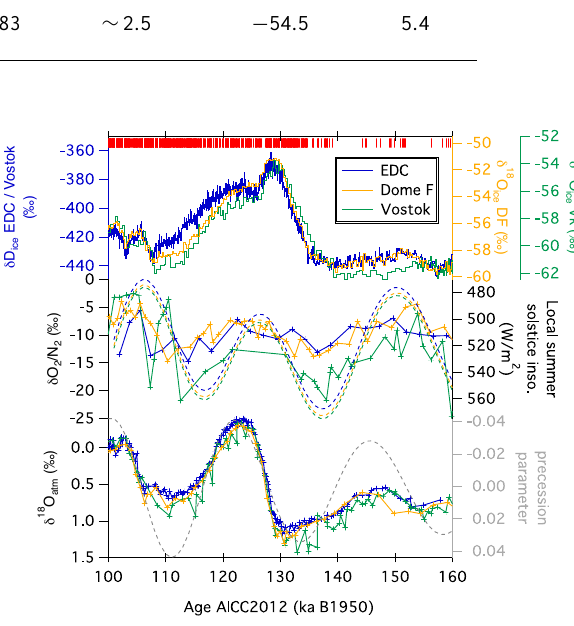
Table 1. Summary of present day local conditions at Vostok, Dome F and EDC (Masson-Delmotte et al., 2011; Kawamura et al., 2007; Landais et al., 2012; Lefebvre et al., 2012, this study). Site Lat. Elevation No. of days Mean Accu. rate Mean annual 10m wind Long. (ma.s.l.) after 21 Dec albedo (cmweqyr − 1 ) temp. ( ◦ C) speed for max temp. (ms − 1 ) 78 ◦ 28’S Vostok 3488 10 0 . 83 2 . 15 − 55 . 3 4 . 2 106 ◦ 48 (cid:48) E 77 ◦ 19’S Dome F 3810 0 0 . 80 75 ◦ 06’S EDC 3233